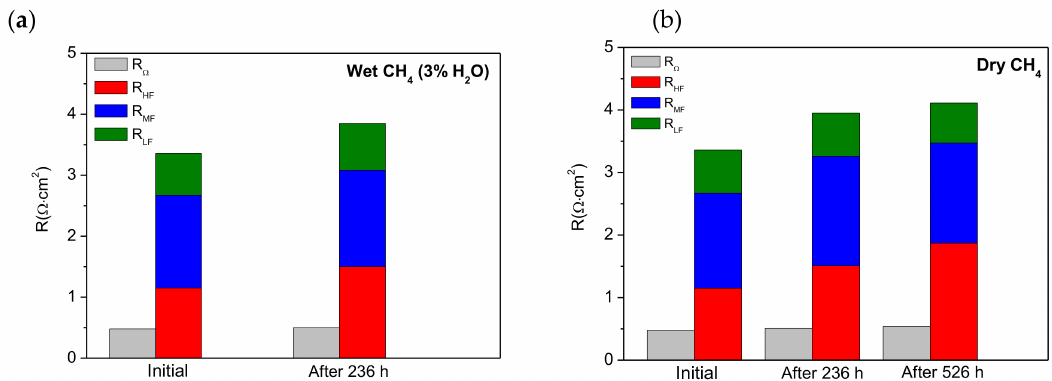
Figure 7. The R Ω , R HF , R MF , and R LF values obtained from the impedance fitting to the equivalent circuit measured for the cell at 850 ◦ C: ( a ) before and after 236 h operation in wet CH 4 (3% H 2 O) and ( b ) before and after 236 and 526 h operation in dry CH 4